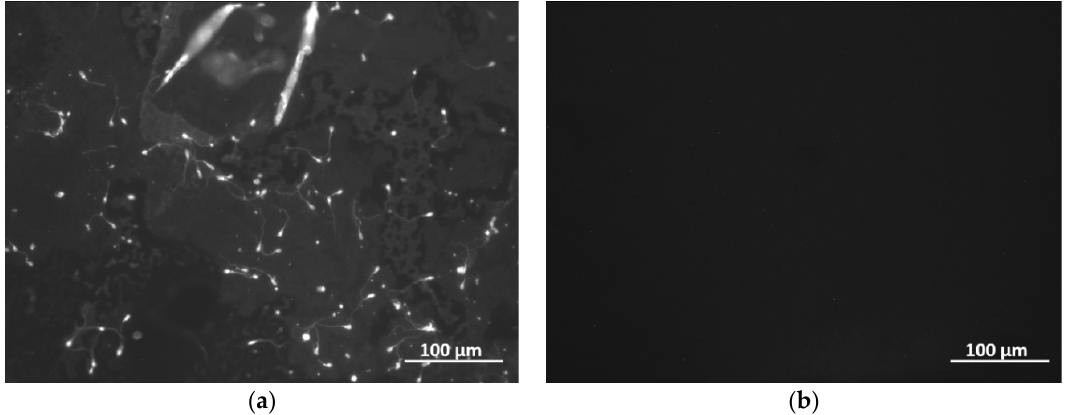
Figure 8. Fluorescence microscopy images of the ( a ) wet and ( b ) dry parts of soot coated glass slide after removal of the specimen from Global medium with HSA and motile human spermatozoa.